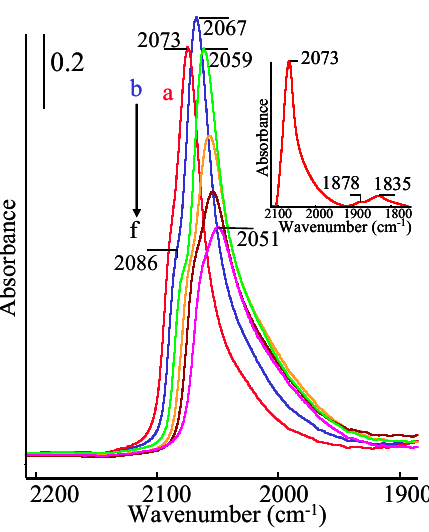
Figure 1. Evolution of the IR band of the linear CO species adsorbed on a reduced 2.9% Pt/Al 2 O 3 catalyst with the adsorption temperature T a at P a = 1 kPa. (a–f) T a = 378, 453, 533, 633, 693 and 783 K. Insert: IR bands of the different adsorbed CO species on 2.9% Pt/Al 2 O 3 for T a = 300 K and P a = 1 kPa.